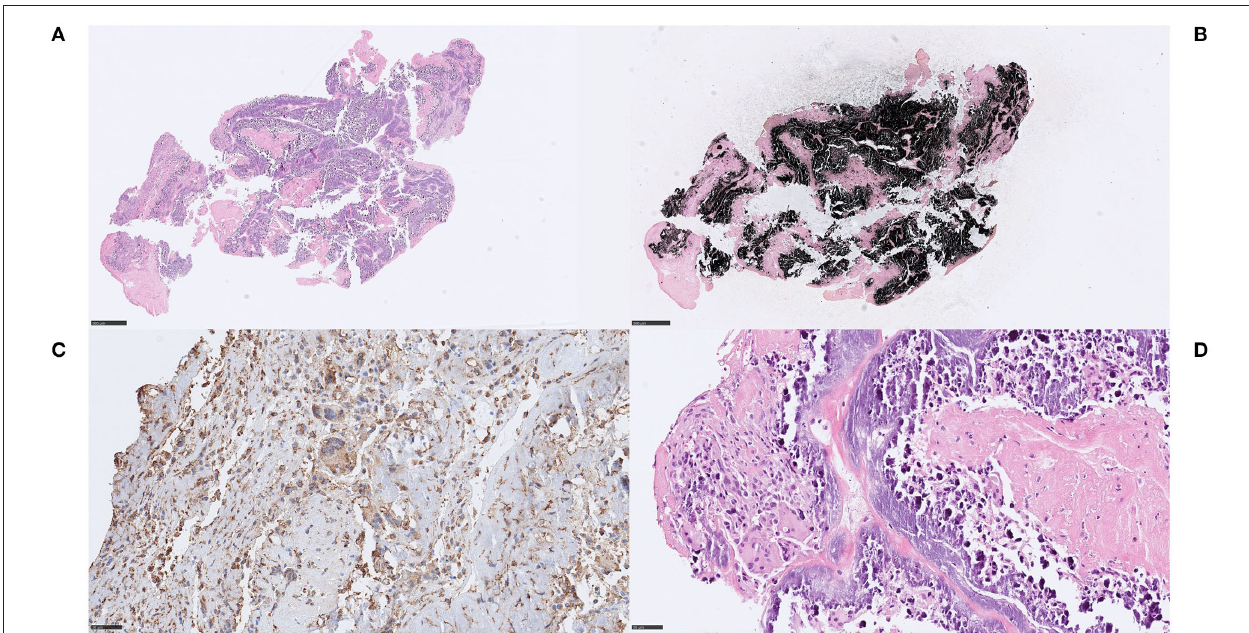
FIGURE 3 | Extracellular DNA (ecDNA) with calcifications. Microcalcific type. Case 1.1: Microcalcific type displayed a dense network of ecDNA staining positive for the DNA stain Feulgen (not shown), intermixed with punctate, extracellular deposits of micromineralization (A) H&E, 50x; 3D, H&E, 400x. The micromineralizations associated with the ecDNA, as well as the ecDNA, stained heavily with von Kossa, confirming content of calcium (B) , von Kossa, 50x. Within the microcalcified component, a completely dominant cell population of anti-CD68-positive cells was evident (C) , CD68, 400x. These cells displayed an immunohistochemically estimated proliferation index of 50–60% with anti-Mib-1 (Ki67) (not shown). The findings, including the absence of neutrophils, indicate that this cell population consisted of macrophages exerting substantial ribosomal RNA synthesis, which in turn may suggest that macrophages could be the source of the ecDNA. Furthermore, frequent multi-nucleated giant cells were seen, however their pathophysiological role and significance in this setting is not certain. (D) H&E, 400x. For 50x, scale bar = 500 µ m; for 400x, scale bar = 50 µ m